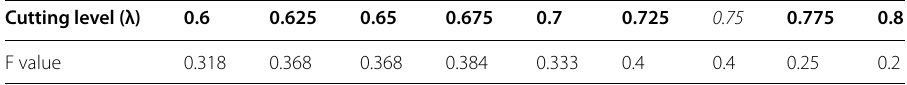
Table 14 Sensitivity analysis on cutting level (λ) in ELECTRE-TRI Cutting level